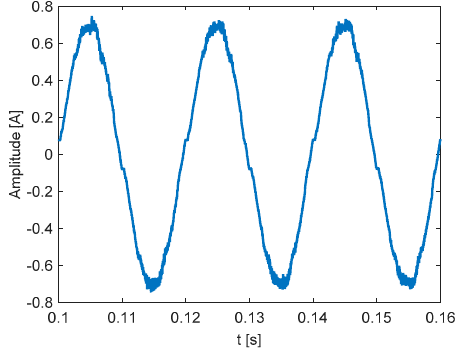
Figure 8. Case study 3: Actual current waveform.